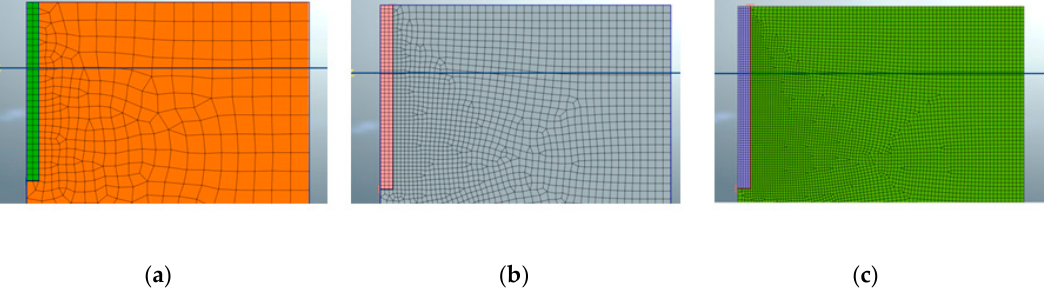
Figure 3. Finite element meshes with different sizes. ( a ) Coarse mesh, ( b ) medium mesh, ( c ) fine mesh.